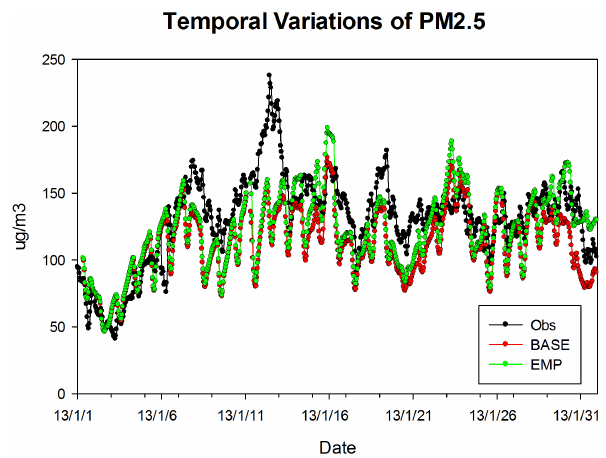
Figure 6. Comparison of observed (black) and simulated (red for the BASE scenario and blue for the EMP scenario) hourly near- surface PM 2 . 5 mass concentrations averaged over 71 cities in China in January 2013.